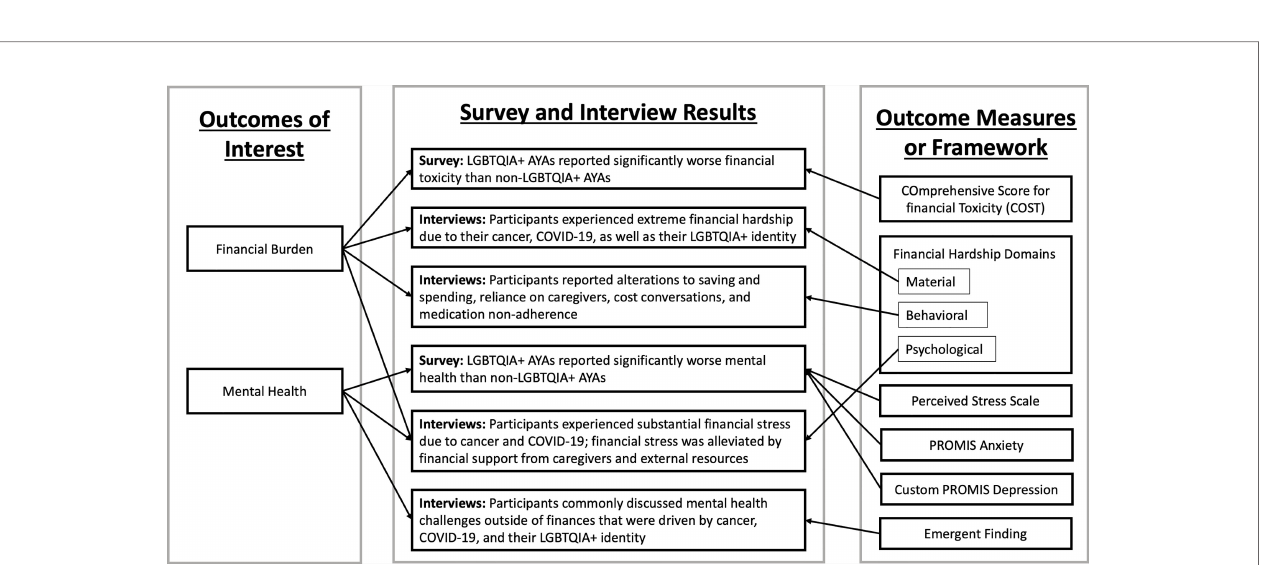
FIGURE 2 | Integration of Survey and Interview Results and Corresponding Outcome Measures or Framework.